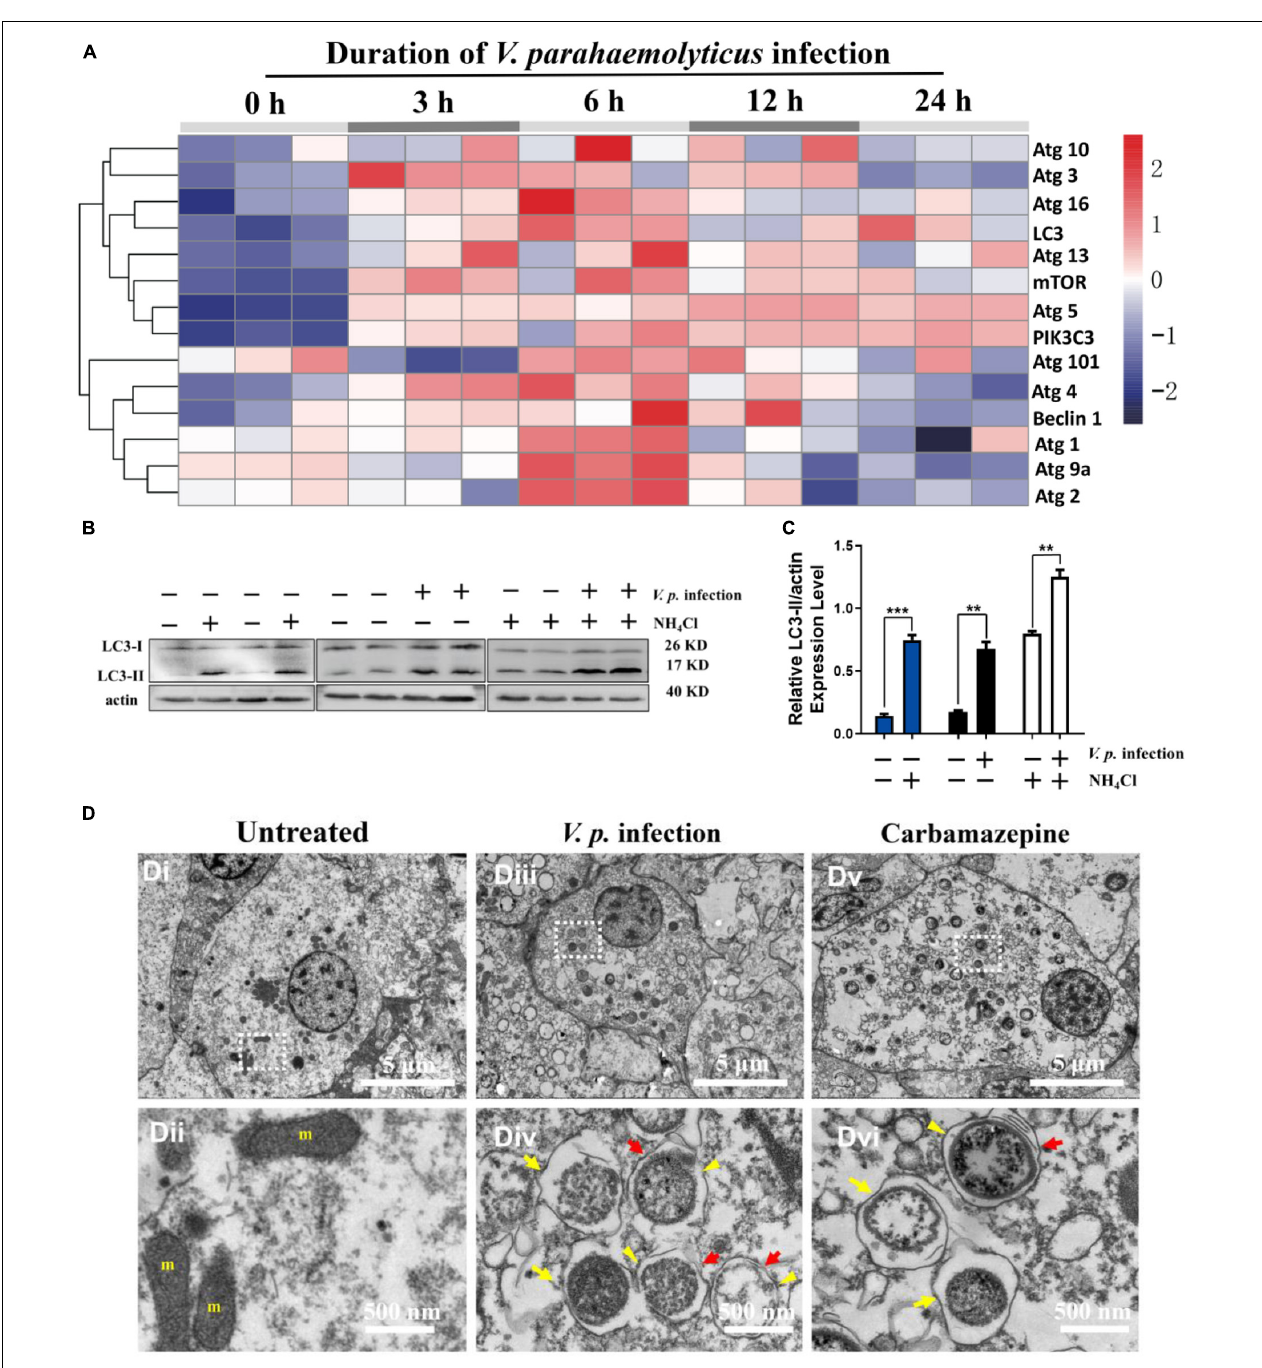
FIGURE 1 | V. parahaemolyticus infection induces autophagy in hemocytes of the Hong Kong oyster. (A) Heatmap showing the profile of autophagy-related genes expressed in C. hongkongensis hemocytes at 0, 3, 6, 12, and 24 h after V.p. infection as detected by quantitative real-time PCR with GAPDH as an internal control. Data are scaled by z score ( n = 3 biological replicates). (B) Western blot for LC3 expression in vivo in hemocytes before and after bacterial infection (for 6 h), with NH 4 Cl as an autophagy inhibitor. (C) Ratio of LC3-II to β -actin in densitometric analysis by Student’s t -test between two groups. Data are presented as mean ± SEM ( n = 3), with statistical significance determined at ** p < 0.01, *** p < 0.001. (D) Ultrastructural morphology of autophagic vacuoles in hemocytes by transmission electron microscopy. (Di,ii) Representative electron micrographs of hemocytes in resting condition (untreated). (Dii) Region at a higher magnification for the inset in (Di) , showing few autophagic vacuoles present in the cytosol. (Diii,iv) Representative electron micrographs of hemocytes at 6 h post-infection ( V.p . infection). (Div) Region at a higher magnification for the inset in panel (Diii) , showing single (yellow arrow) and double (yellow arrowhead) membranes with electron-lucent clefts (red arrow). (Dv,vi) Representative electron micrographs of hemocytes exposed to an autophagy inducer (carbamazepine). (Dvi) Region at a higher magnification for the inset in panel (Dv) , showing single (yellow arrow) and double (yellow arrowhead) membranes with electron-lucent clefts (red arrow). m, mitochondria.